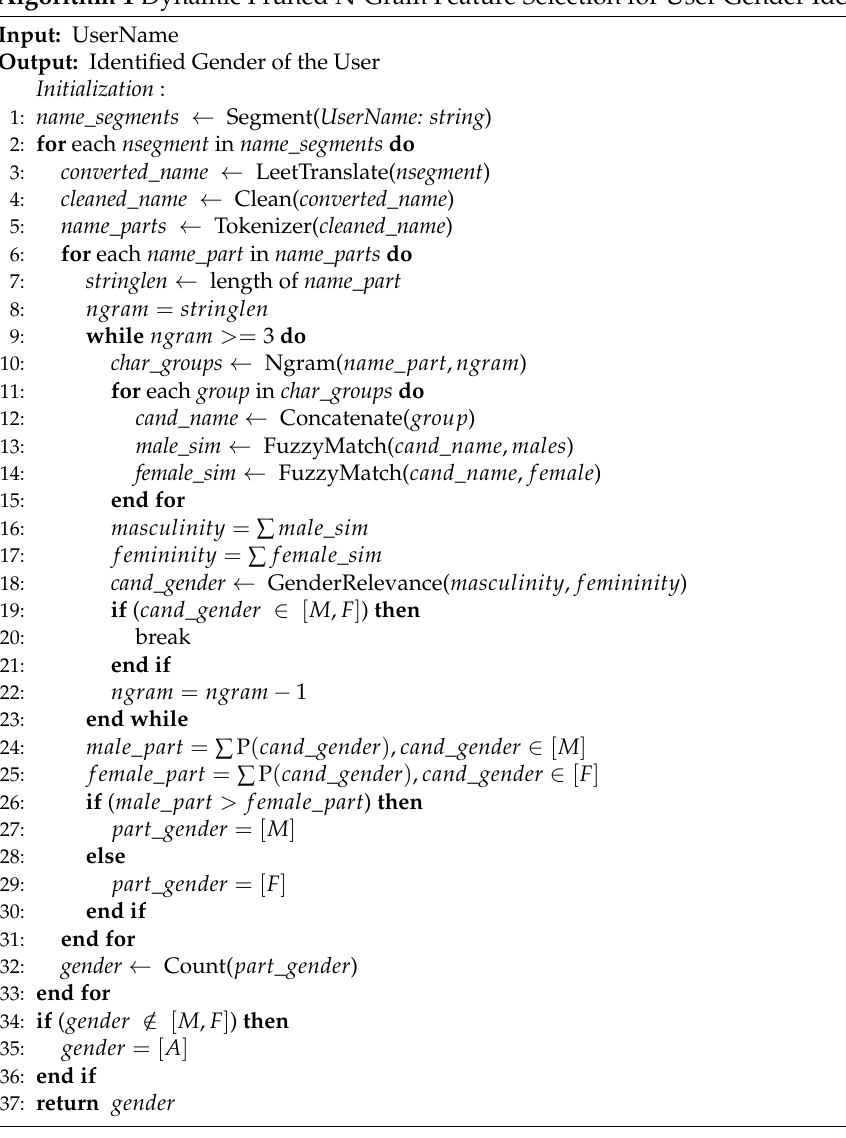
Algorithm 1 Dynamic Pruned N-Gram Feature Selection for User Gender